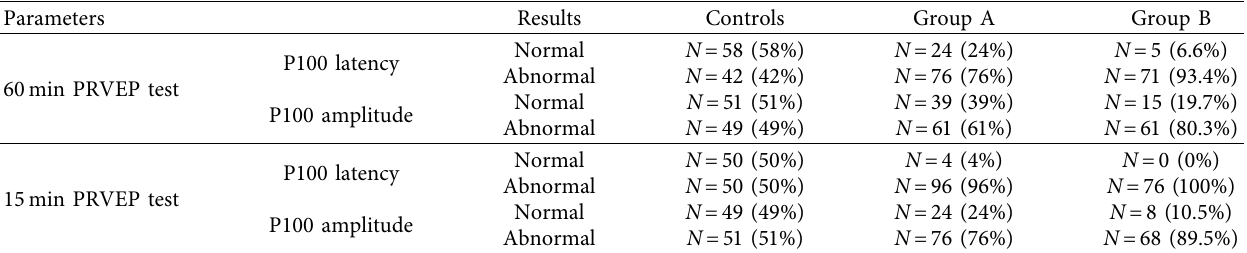
Table 3: The proportion of normal and abnormal PRVEPs test results.